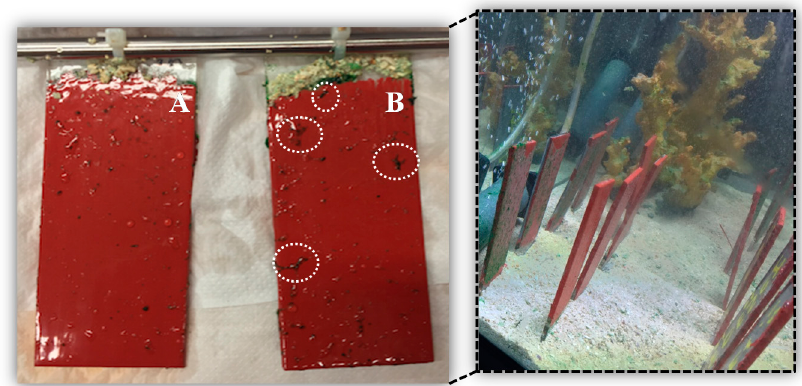
Figure 3. Representative Silicone-based coatings with immobilised Econea biocide (<0.6 wt. %) ( A ) and respective Reference ( B ) without biocide after 1.5 years in an artificial seawater